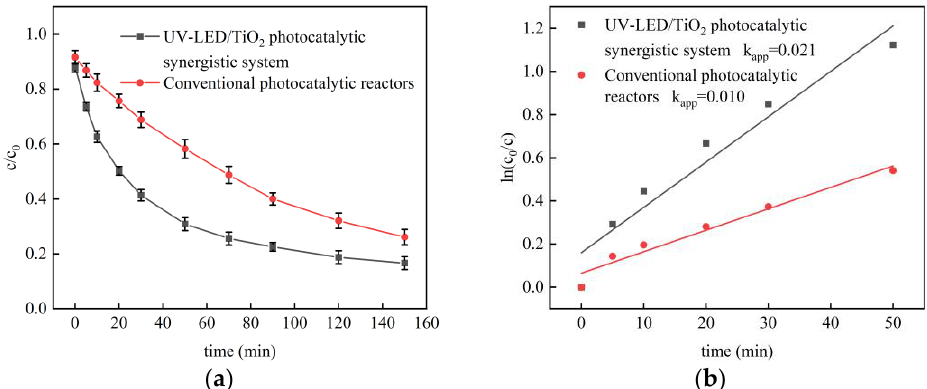
Figure 11. ( a ) Comparison of wastewater degradation performance between UV-LED/TiO 2 photo- catalytic synergistic system and conventional photocatalytic reactor when the wastewater flow rate was 80 mL/min, the temperature was 20 °C, initial AR 26 concentration was 45 mg/L, TiO 2 concen- tration was 0.75 g/L and pH = 2; ( b ) Kinetic fit for two photocatalytic